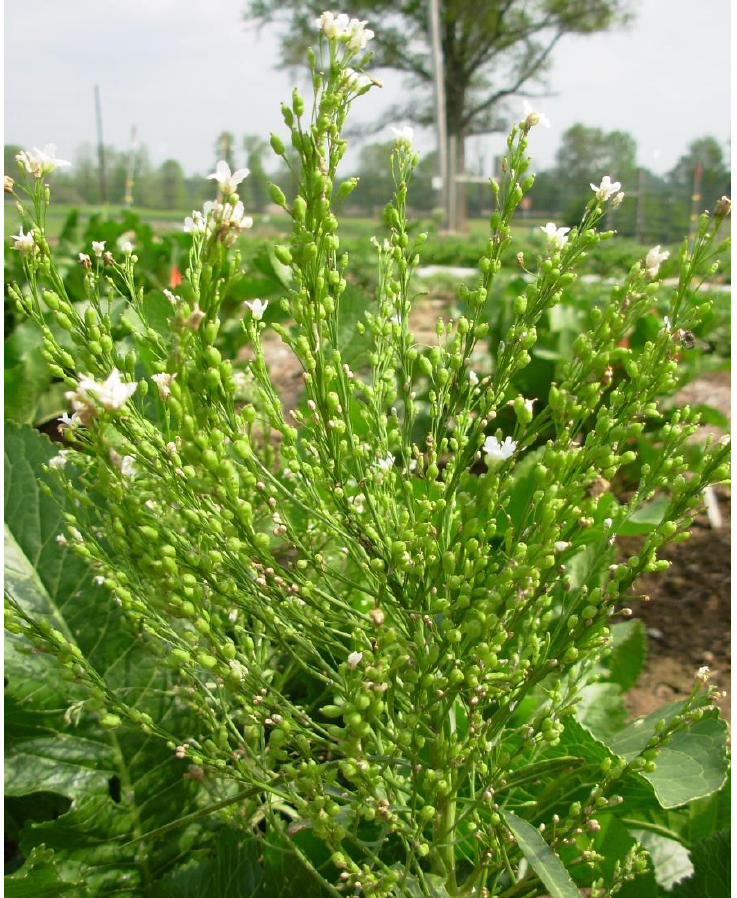
Figure 1. Horseradish inflorescence with maturing seed pods during mid-spring outdoors in a polycross field block (photo by Dr. Alan Walters). Two-year old roots (or crowns) from selected horseradish plant materials are used to develop new genetic combinations since these will produce flowers. The year after significant crown development has occurred, that is from set root (~1.3 cm diam.) to large primary root (>2.5 cm diam.), horseradish plants will naturally flower during the early spring. For intercross blocks, horseradish plants will flower the spring after they are placed into the ground during mid-spring the previous year. Many crowns used for making specific targeted crosses under greenhouse conditions are harvested during the autumn and placed into cold storage for about 3 months since they can be forced to flower under greenhouse conditions, if previously provided at least two months of cold treatment at 0 to 5 ◦ C. These crowns are removed from cold storage and are usually planted into large pots in early- to mid-March, with flowers appearing three to four weeks later. Seeds are ready to harvest by mid-May and mid-June for those obtained from the greenhouse and field, respectively. Ripened seed pods are collected, with seeds